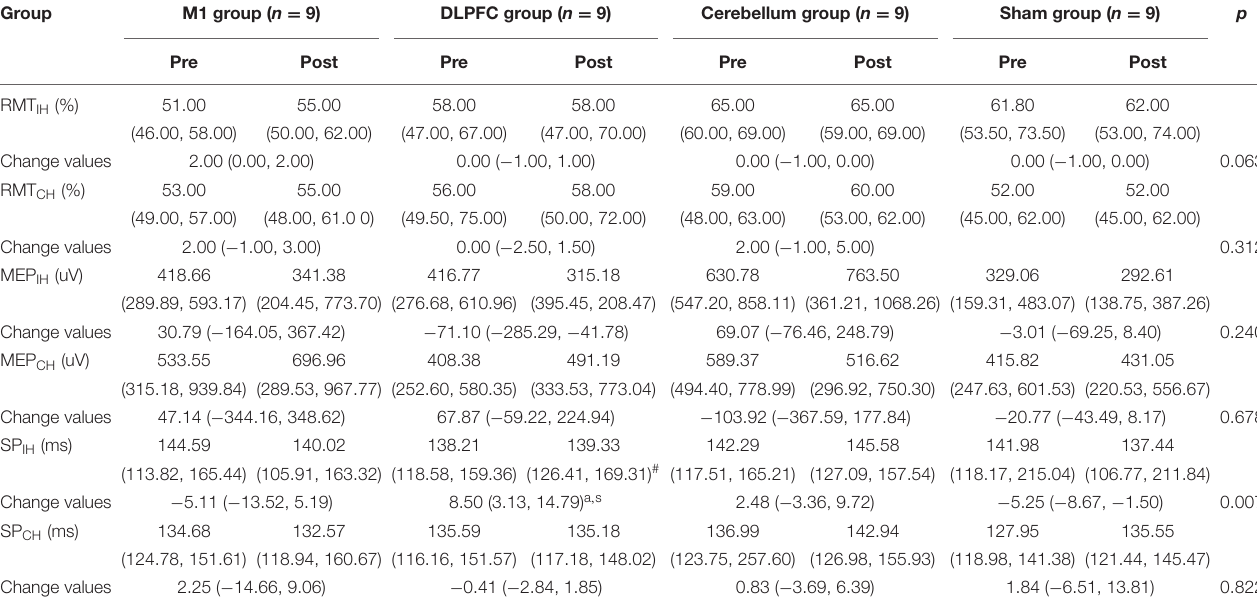
TABLE 3 | Corticospinal activity after different tDCS interventions.